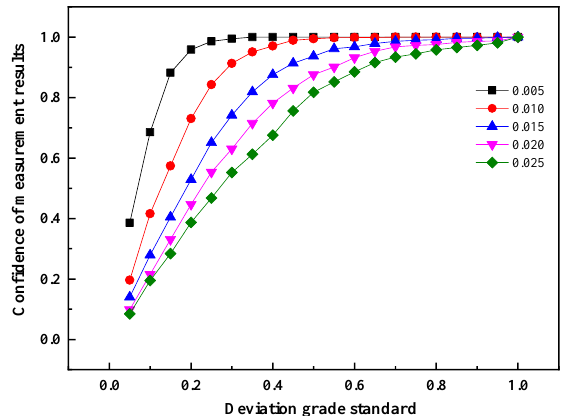
Figure 20. Relationship between deviation grade standard and confidence of measurement results under different relative standard deviations of temperature at velocity 2.1 m/s.